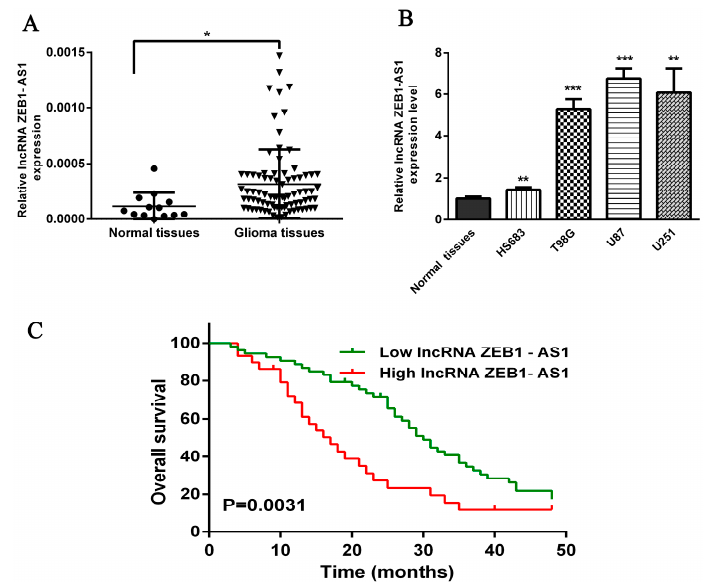
Figure 1. Relative expression of the long noncoding RNA (lncRNA) ZEB1-AS1 in glioma tissues and its clinical significance. ( A ) qRT–PCR analysis of ZEB1-AS1 expression level in 13 normal brain tissues and 82 glioma tissues; ( B ) The expression of ZEB1-AS1 in glioma cell lines and normal brain tissues; ( C ) Patients with high levels of ZEB1-AS1 expression were correlated with a poor overall survival in glioma ( p = 0.0031, Kaplan-Meier method). * p < 0.05, ** p < 0.01, *** p < 0.001.